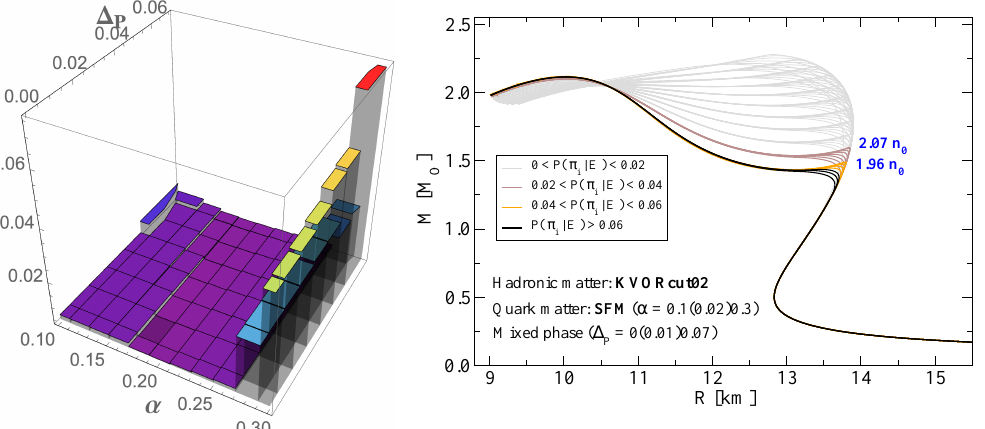
Figure 4. Left panel: The posterior distribution of models on the parameter space spanned by ∆ P and α . Right panel: The compact star sequences in the mass–radius diagram labeled into four probability classes according to the results of the BA for the posterior distribution of the left panel. The grey, brown, orange and black lines show sequences for which the value of the posterior probability exceeds the thresholds of 0.0, 0.02, 0.04 and 0.06, respectively. Due to the restriction to the model and parameter range used in Ref. [32], the sequences with a lower onset mass for the deconfinement transition are not accessed for which an interpretation of GW170817 as a merger of two hybrid stars would be